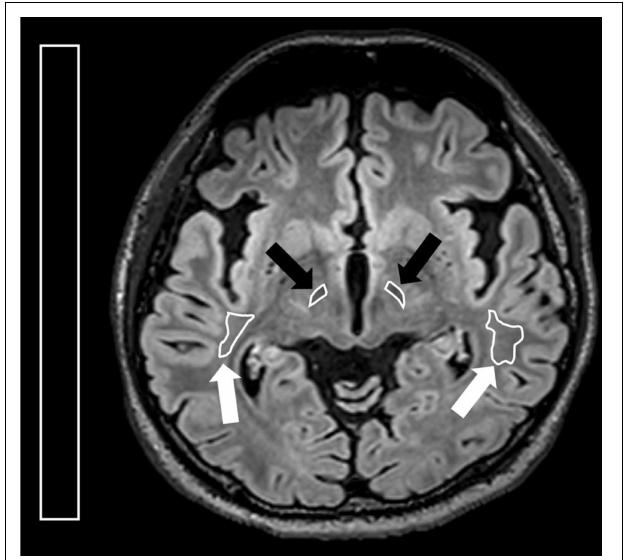
FIGURE 3 | Illustration for regions of interest (ROIs) placed on the axial FLAIR image. On the axial image with the optimal visualization of both subthalamic nucleus, ROIs were placed at bilateral STN (black arrows) and corona radiata (white arrows). A rectangular ROI of the background area with an area greater than 10.0 cm 2 was placed on the right side of the